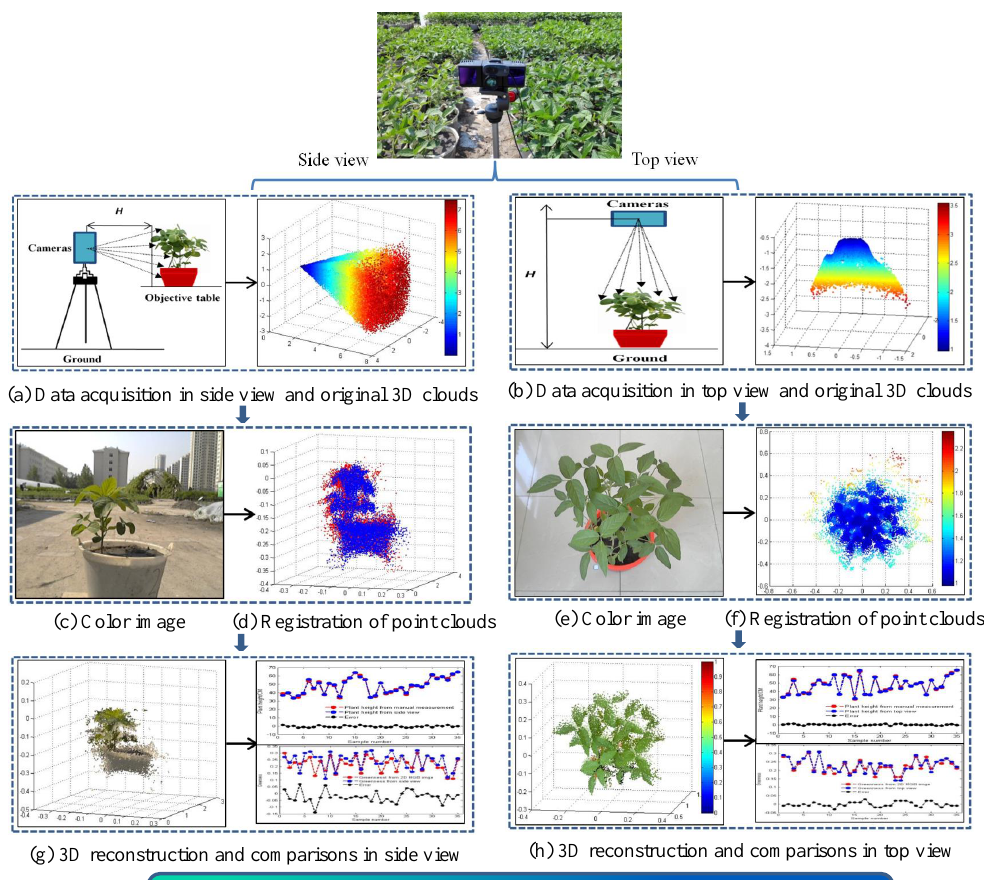
Figure 1. Framework for the three-dimensional (3D) reconstruction of soybean canopies.